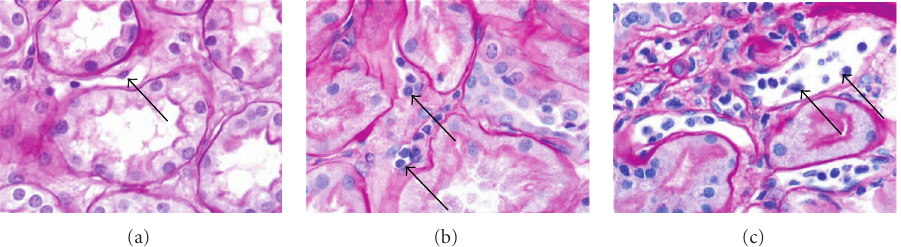
Figure 1: Periodic acid schi ff (PAS) staining (X 400) of renal biopsies. (a) No acute rejection, (b) acute rejection grade IA, (c) acute rejection grade IIA. Arrows show peritubular capillary endothelial